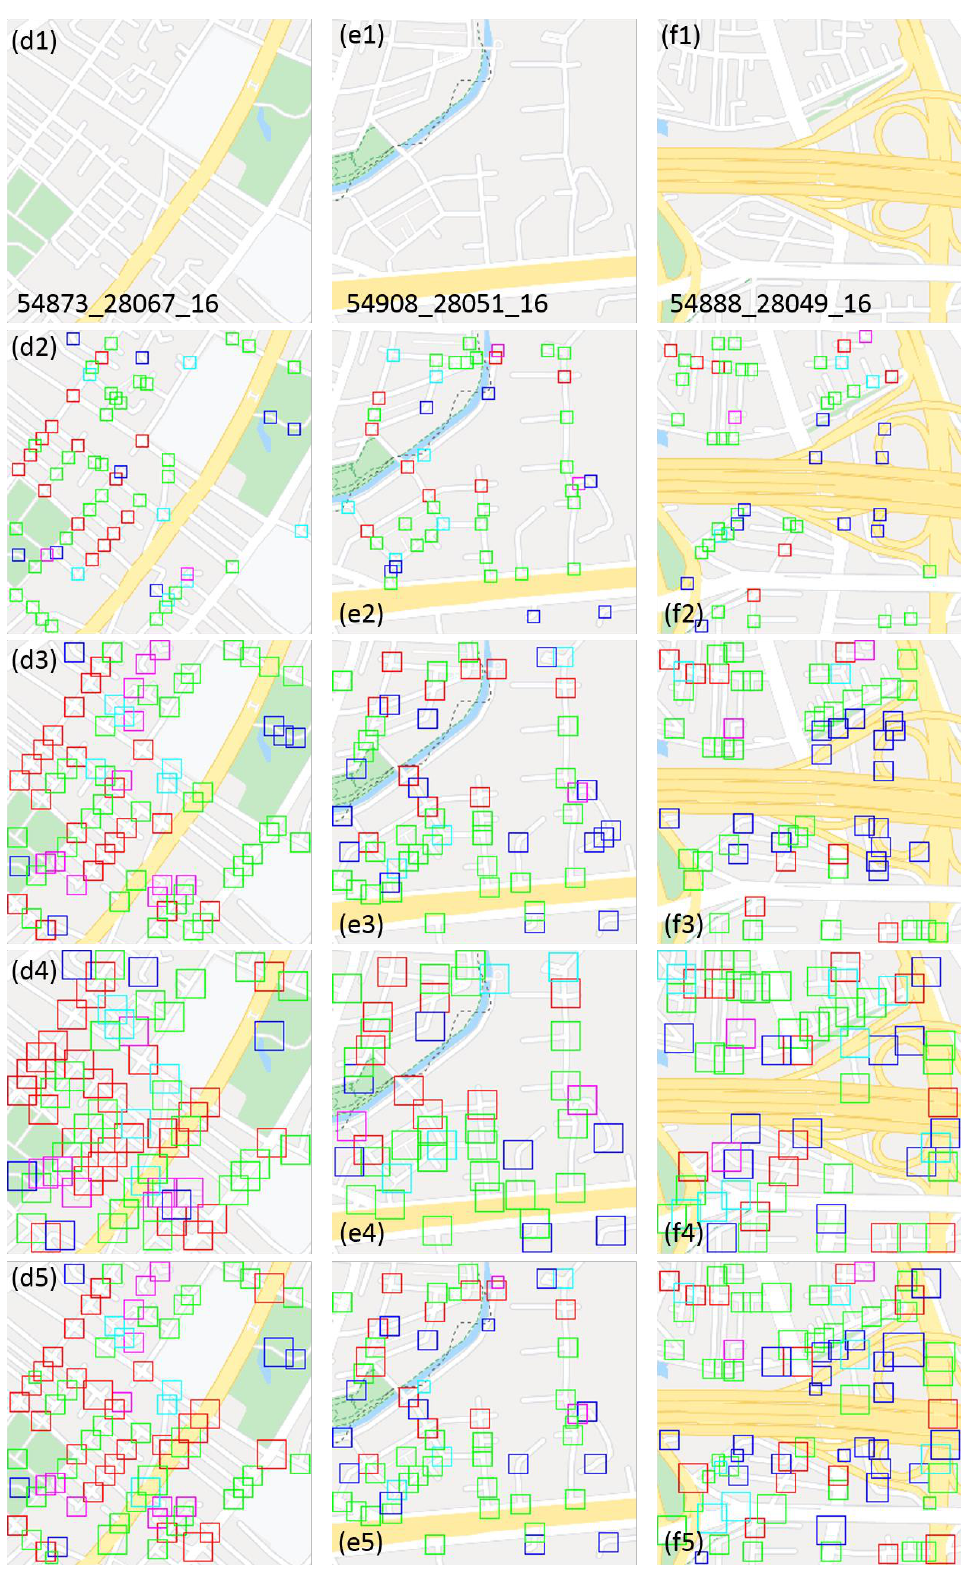
Figure 7. Road characteristics detection results: ( a1 – f1 ) are original tiles numbered 54897_28039_16, 54880_28041_16, 54876_28052_16, 54873_28067_16, 54908_28051_16, and 54888_28049_16. Those from ( a2 – f2 ) are initial results of small size; ( a3 – f3 ) are initial results of medium size; ( a4 – f4 ) are initial results of large size; and from ( a5 – f5 ) are final results obtained from three sizes of initial results adopting combination